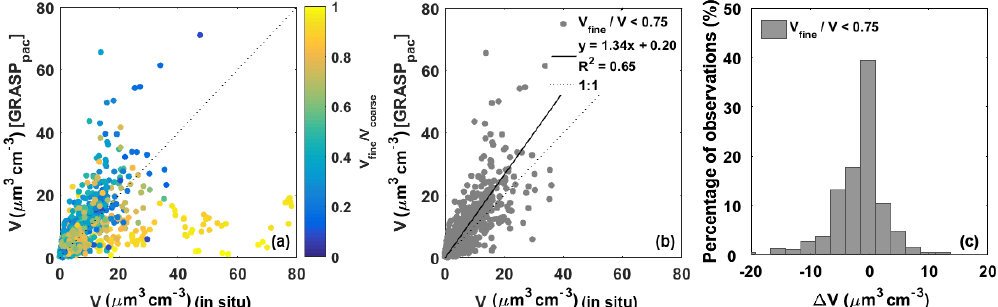
Figure 4. (a) Scatter plot of the hourly averaged aerosol volume concentration determined with GRASP pac from the ceilometer and pho- tometer data at MSA height versus the in situ concentrations at low ambient RH (RH ambient < 50%), with the color scale representing the contribution of fine particles to the total volume concentration. (b) Same as panel (a) but restricted to situations with contribution of fine particles to the total aerosol volume concentration < 75% ( V fine /V < 0 . 75). (c) Frequency of occurrence of the absolute difference between the volume concentrations measured in situ and determined with GRASP pac for situations with V fine /V < 0 .